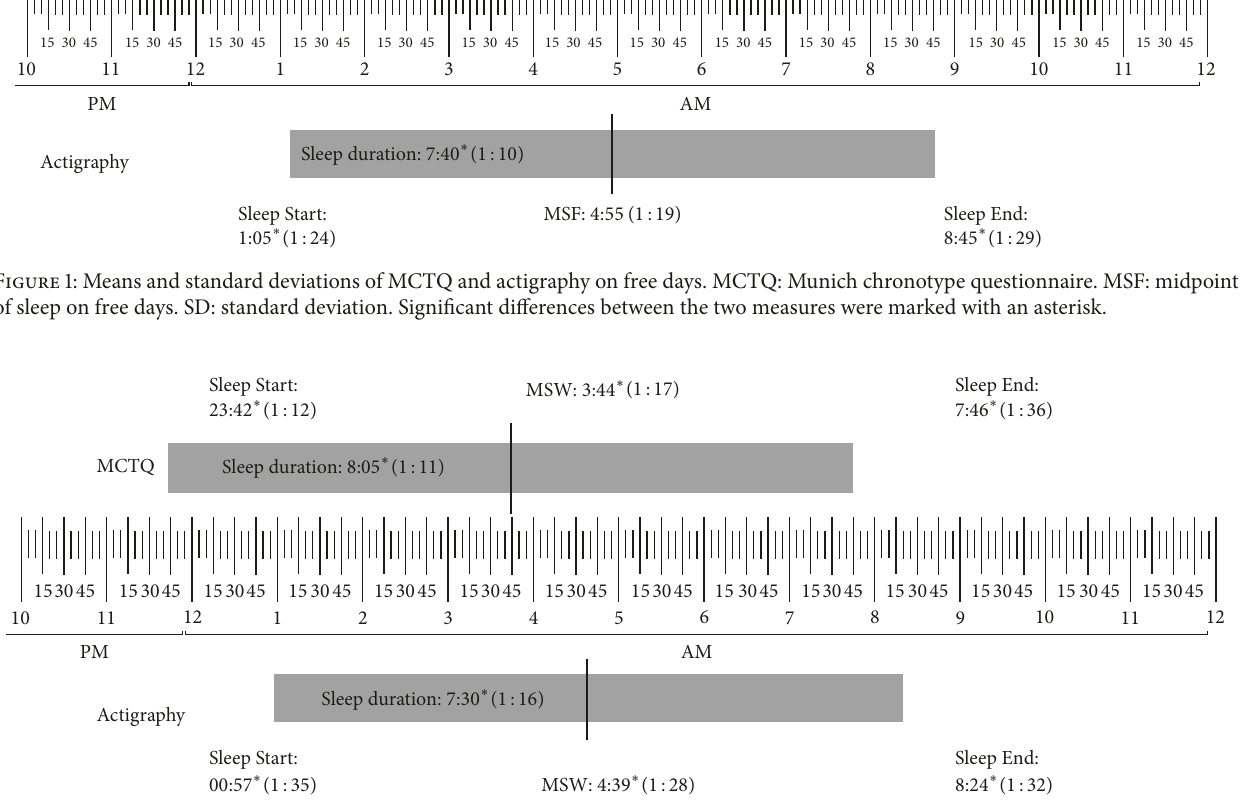
𝑝 = 0.51 , and 𝑑 = 0.06 ). A strong correlation was found between these two measurements ( 𝑟 (88) = 0.73 , 𝑝 < 0.001 )